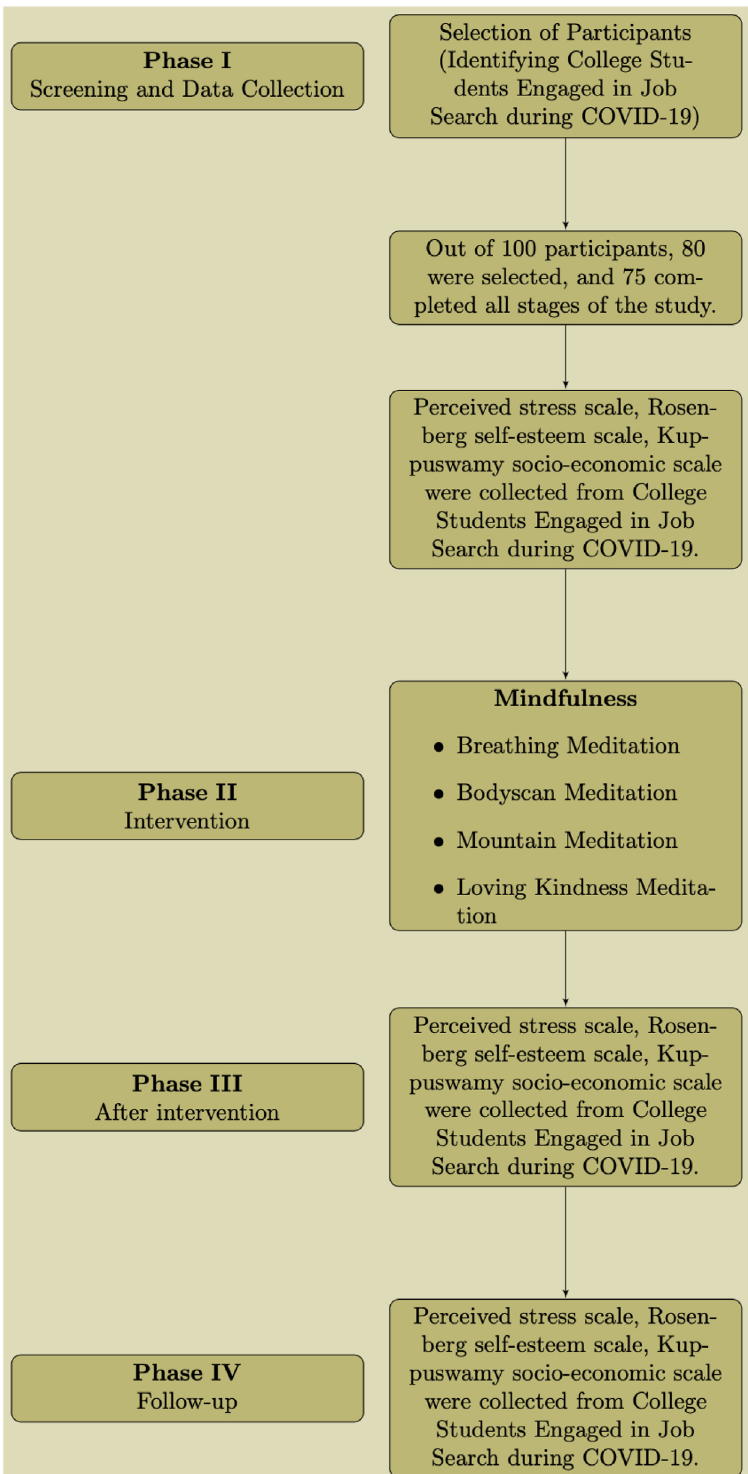
Figure 1. Process